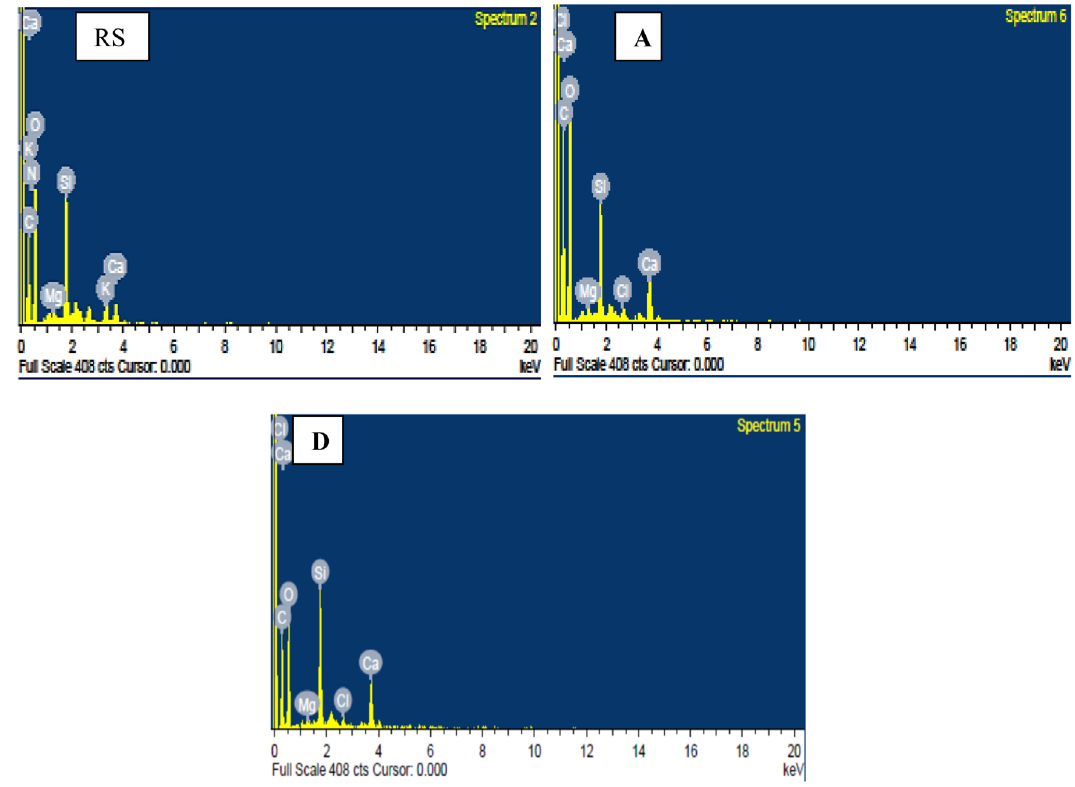
Figure 2. Energy dispersive X-ray spectrographs of native ( RS ), PWW pretreated ( A ) and distilled water pretreated ( D ) rice